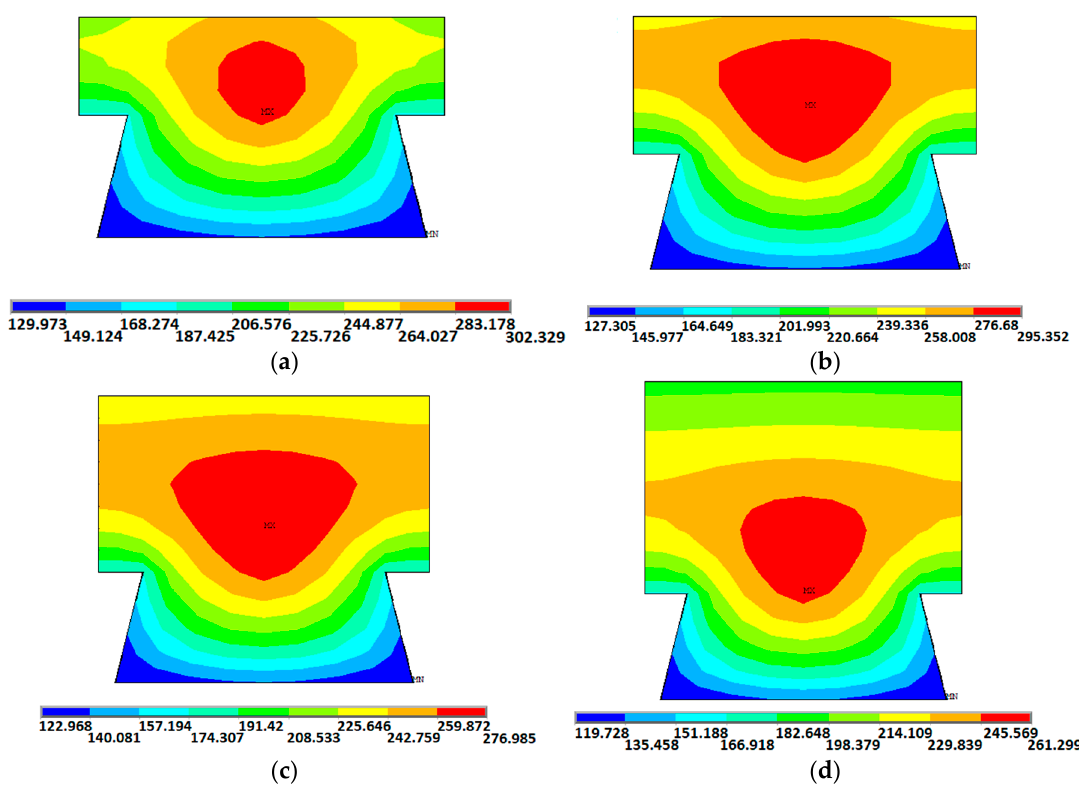
Figure 11. Temperature profile during the cooling phase of the composite slab Multideck 50 for different values of h 1 : ( a ) h 1 = 40 mm; ( b ) h 1 = 60 mm; ( c ) h 1 = 80 mm; ( d ) h 1 = 100 mm.